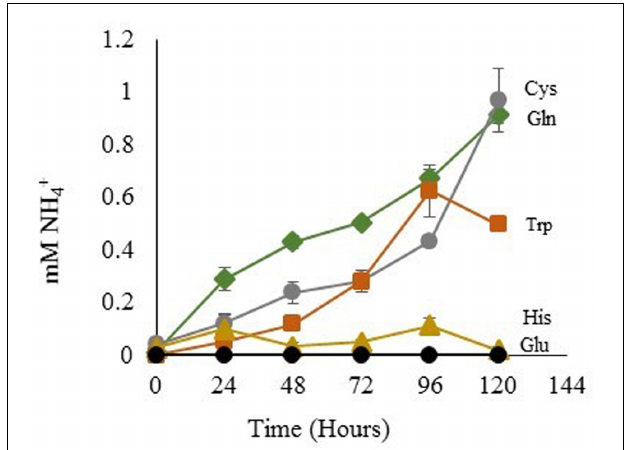
FIGURE 6 | NH 4 + Released from amino acids in sterile media. Glutamic • Acid ; tryptophan (cid:4) ; histidine (cid:78) ; glutamine (cid:7) ; cysteine Standard Deviation of three independent replicates are